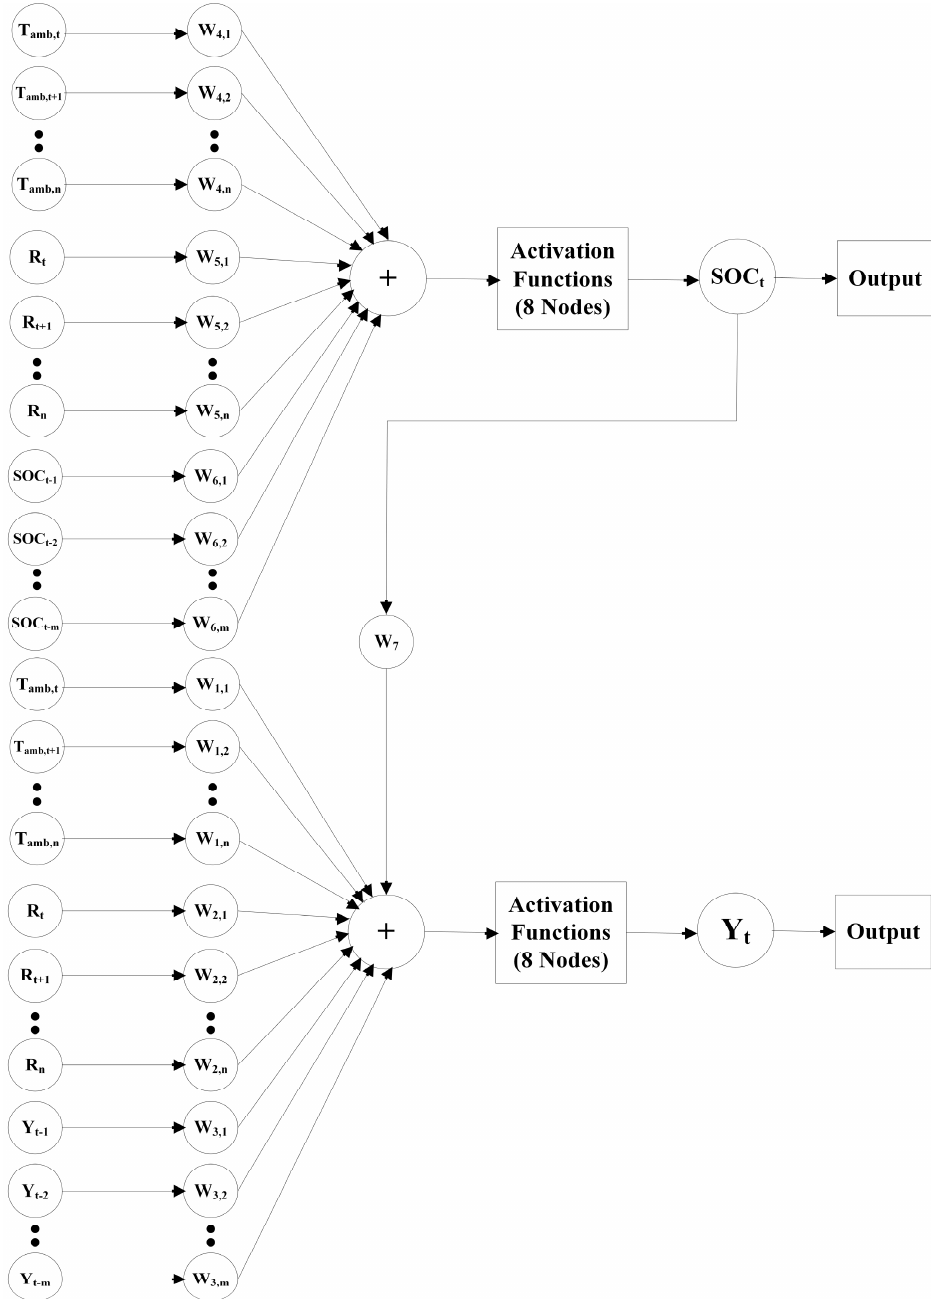
Figure 12. A diagram for the structure of the N ‐ ARXnet two ‐ step prediction model.